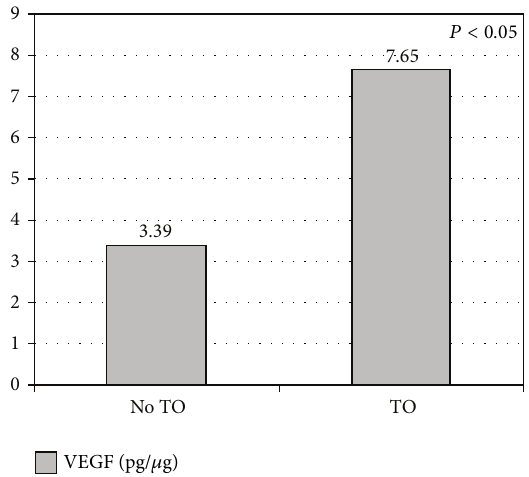
Figure 6: Vascular endothelial growth factor, VEGF, in fetuses with congenital diaphragmatic hernia. Comparison of tracheal occlusion versus no tracheal occlusion. Values are expressed as mean in pg/ 𝜇 g.